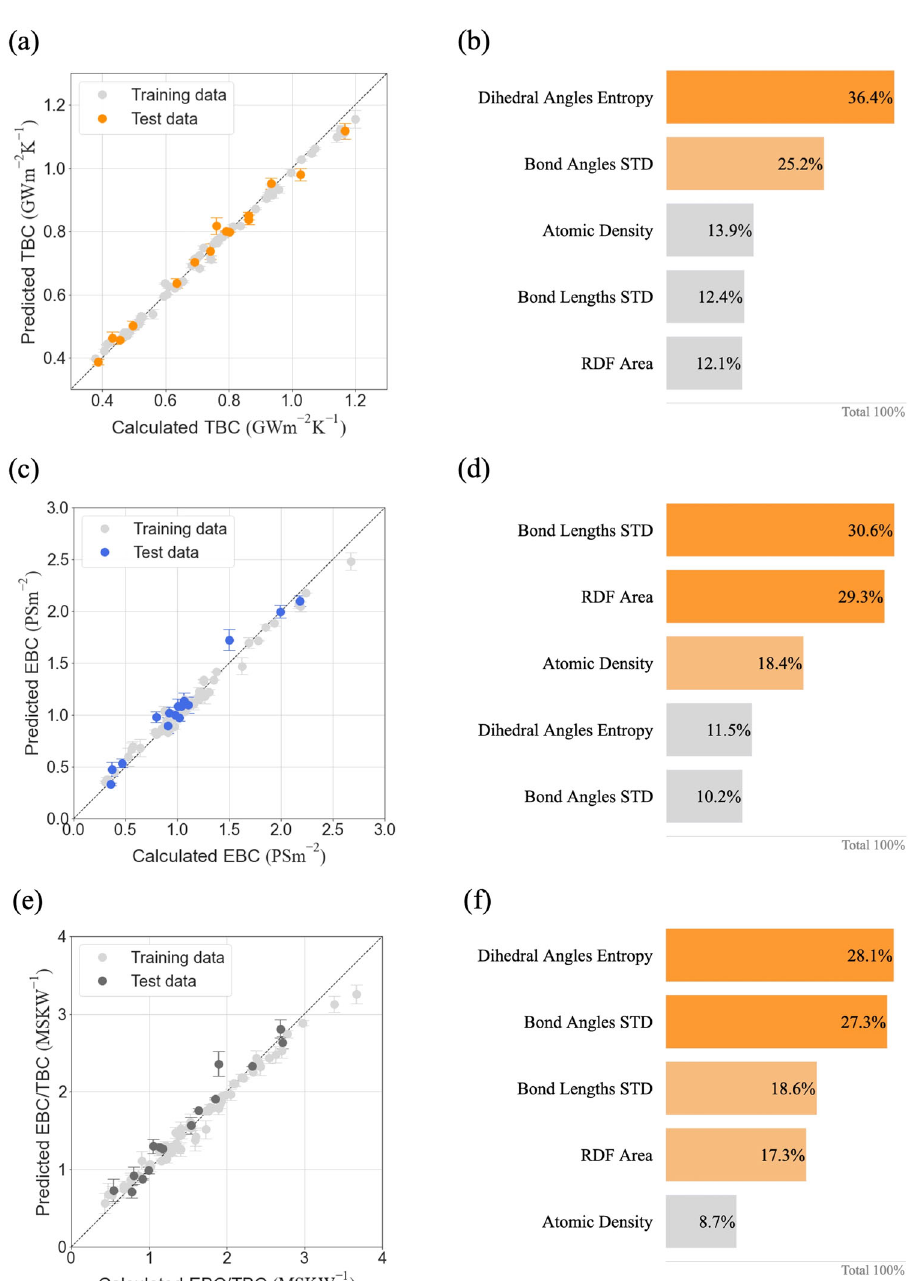
Fig. 6 Prediction results of 75 crystalline – crystalline grain boundaries that are electroincally realistic. Panels a , c , and e demonstrate parity plots between calculated and ensemble-predicted values with error bars indicating standard deviations of the ensemble predictions, while b , d , and f show feature importance of thermal boundary conductance (TBC), electrical boundary conductance (EBC), and EBC/TBC